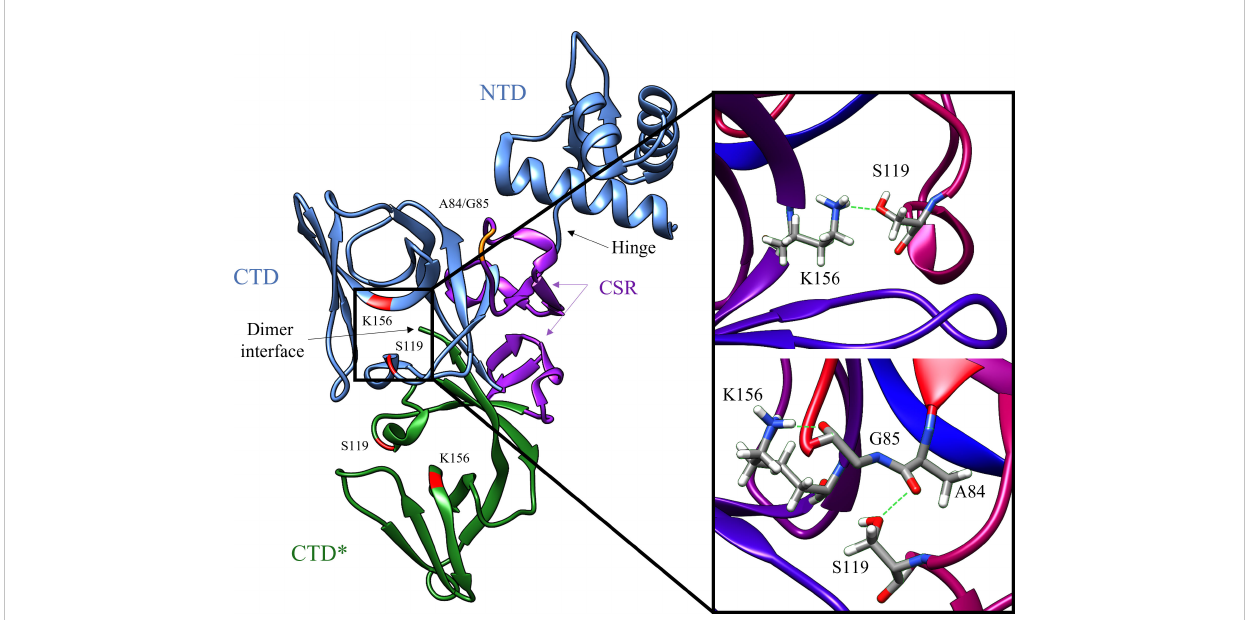
FIGURE 2 Key structural features of the LexA dimer (PDB ID: 1JHF). One of the monomers is depicted in blue, and the other is in green. The catalytic dyad Ser- 119 and Lys156 are highlighted in red, and the scissile bond Ala-84 – Glu-85 is in orange. The CSR which undergoes the conformational shift upon binding to RecA is shown in purple. The insert depicts the transition from the catalytic S119-K156 dyad to the tetrahedral intermediate (PDB ID: 1JHE) as the scissile Ala-84 – Glu-85 moves into the hydrophobic pocket. This conformational change activates LexA from the NC form into the C form. The green dashed lines in the insert represent the hydrogen bonds between residues in the crystal structure. Note that the crystal structure does not contain the NTD of the second monomer in the dimer, due to poor electron density (Luo et al.,